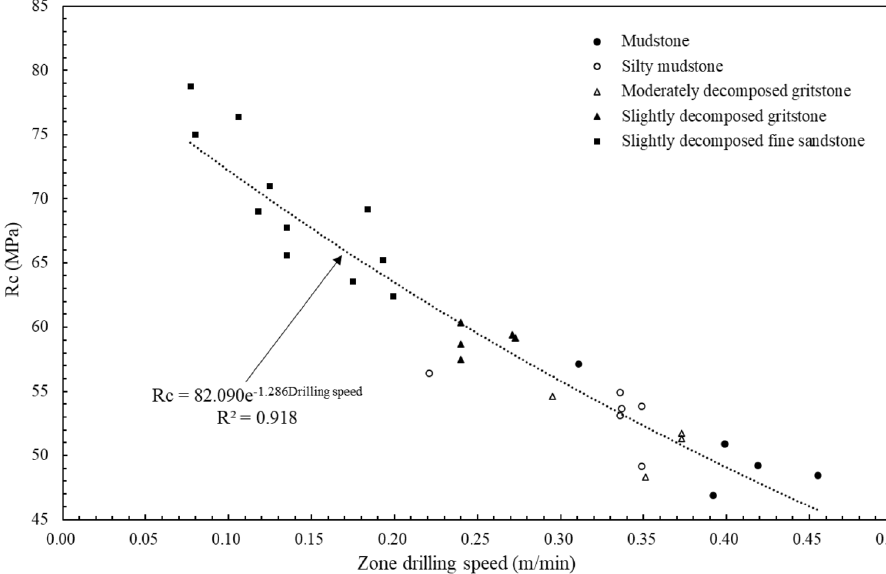
Figure 9. Comparison between the rock uniaxial compressive strength R c from laboratory test and the corresponding zone drilling speed from digitalization